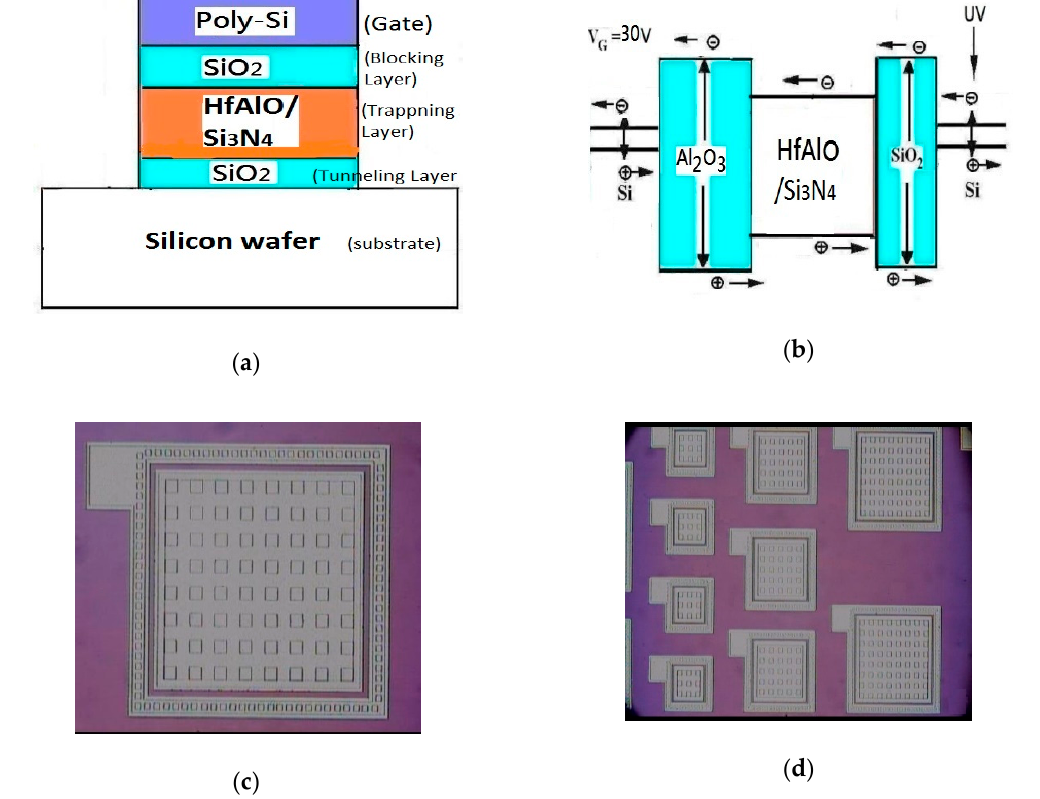
Figure 1. ( a ) Cross-sectional view of SAHAOS/SANOS capacitor device; ( b ) UV-induced charge generation and capture in SAHAOS/SANOS capacitor. ( c ) OM image of SAHAOS/SANOS capacitor with an area of 100 × 100 µ m 2 . ( d ) OM image of SAHAOS/SANOS capacitors with an area of 100 × 100 µ m 2 , 200 × 200 µ m 2 , and 300 × 300 µ m 2 .